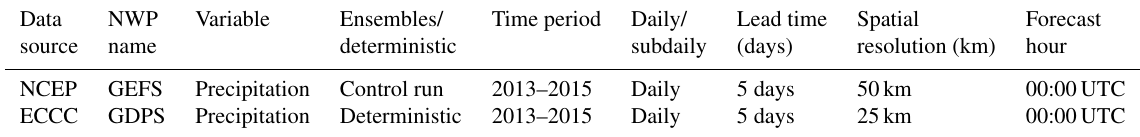
Table 1. Description of precipitation forecasts. Data NWP Variable Ensembles/ Time period Daily/ Lead time Spatial Forecast source name deterministic subdaily (days) NCEP GEFS